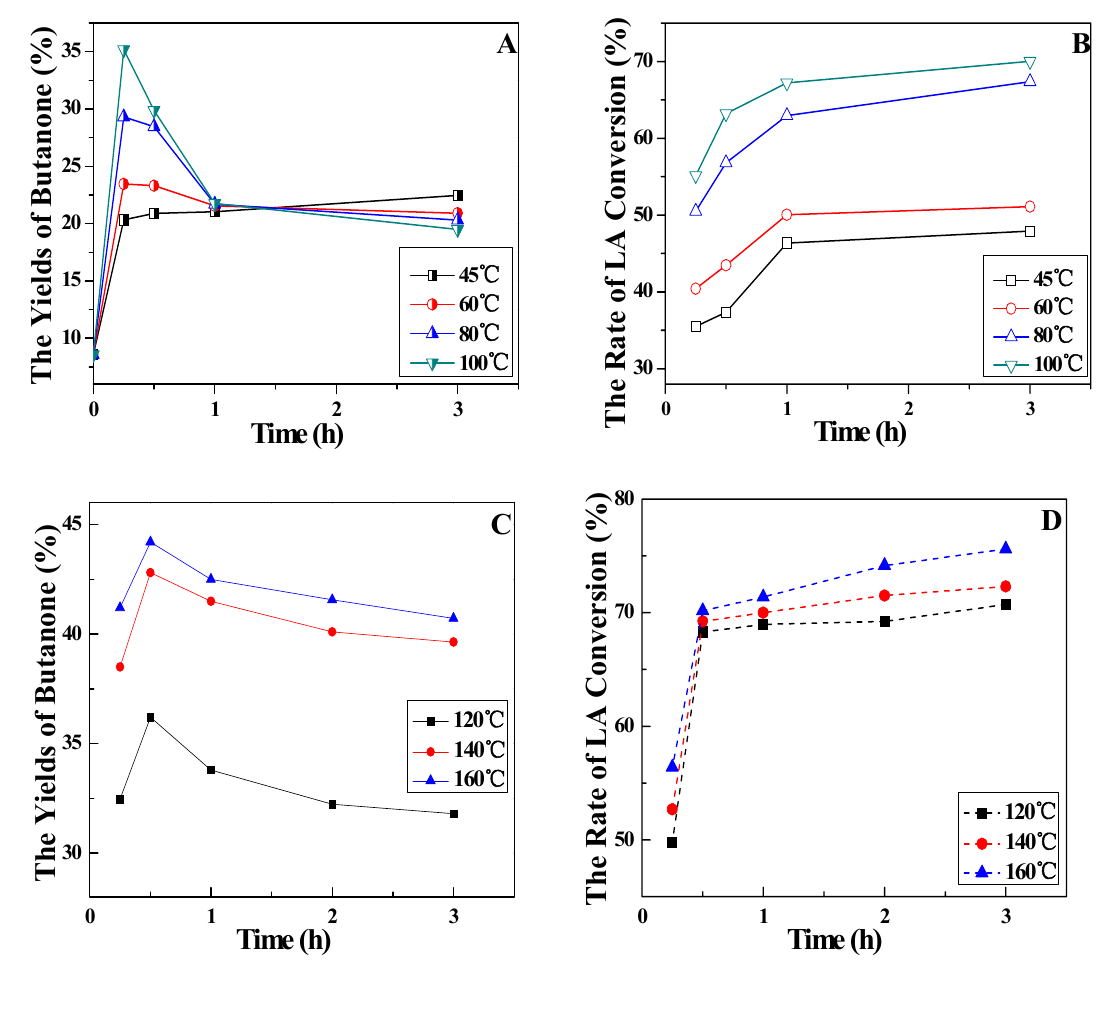
Figure 2. Effect of time on decarboxylation of levulinic acid to 2-butanone {[A] butanone yield ( ≤ 100 °C); [B] LA conversion( ≤ 100 °C); [C] butanone yield ( ≥ 100 °C); [D] LA conversion ( ≥ 100